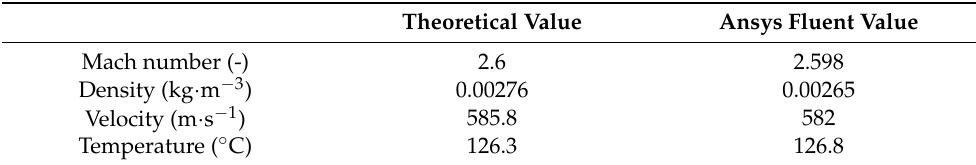
Table 2. Results of comparison of Ansys values with one-dimensional flow theory.